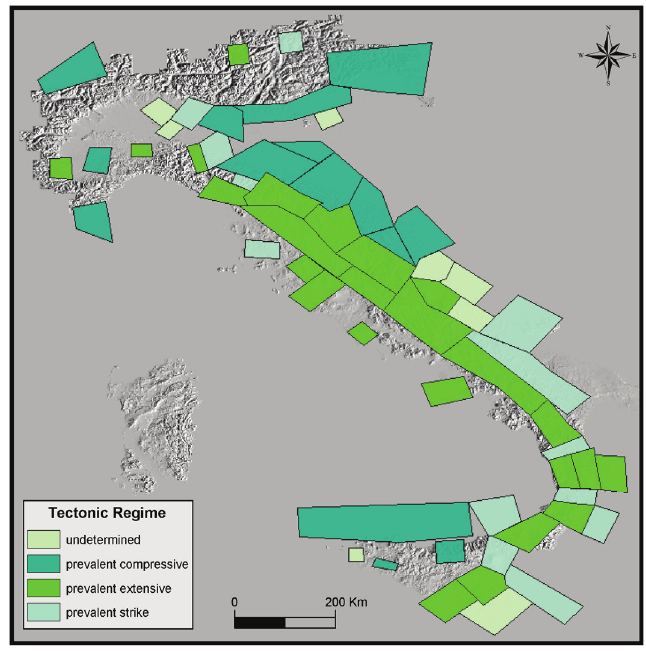
Figure 2. The seismotectonic zonation from Cinti et al. [2004], figure 1d. A total of 61 zones defines the hazard regionalization. The tectonic regimes are shown for each